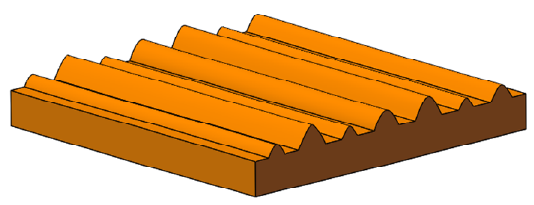
Figure 4. The hypothetical surface.